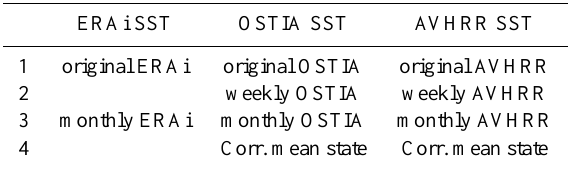
Table 1. Experiments performed with the ECMWF model in atmosphere-only mode and their respective SST forcing for the MJO case of the winter